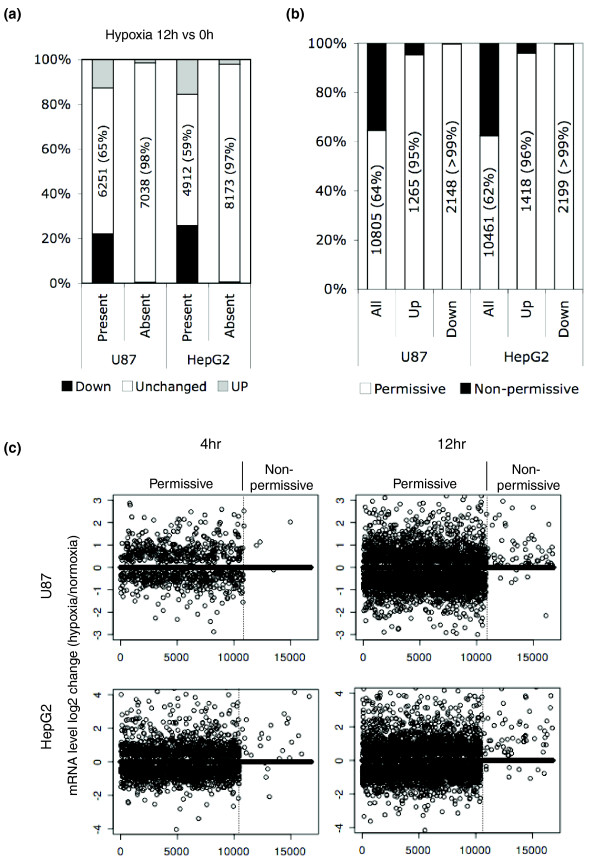
Basal expression level predicts hypoxia-inducibility. (a) Genes were divided based on their MAS5 present/absent calls under normoxic conditions (0 h). In both cell types, most genes whose expression was up- (gray) or down-regulated (black) by hypoxia were already expressed under basal conditions (Present). (b) Approximately 60% of all genes are permissive (H3K4 me3+, RNA Pol II+, or MAS5 present) under normal growth conditions (All, normoxia). Most genes for which mRNA levels were significantly up- or down-regulated upon hypoxia were permissive under normoxia. Statistical significance was determined by Fisher exact test, and was P-value <1e-150 for all pairwise comparisons. (c) For both cell types, genes were partitioned as either permissive or non-permissive under normal growth conditions (t = 0 h). Changes in mRNA levels (log2 scale) after 4 h and 12 h of hypoxia treatment are plotted, with non-significant changes (P-value > 0.01) represented as 0.